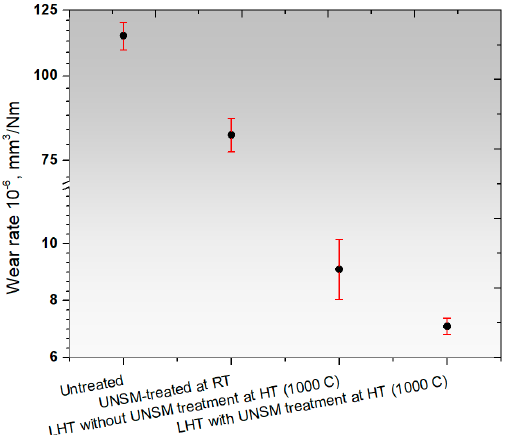
Figure 10. Comparison in wear rate of the untreated, UNSM-treated at RT and LHT without and with UNSM treatment at 1000 °C specimens.